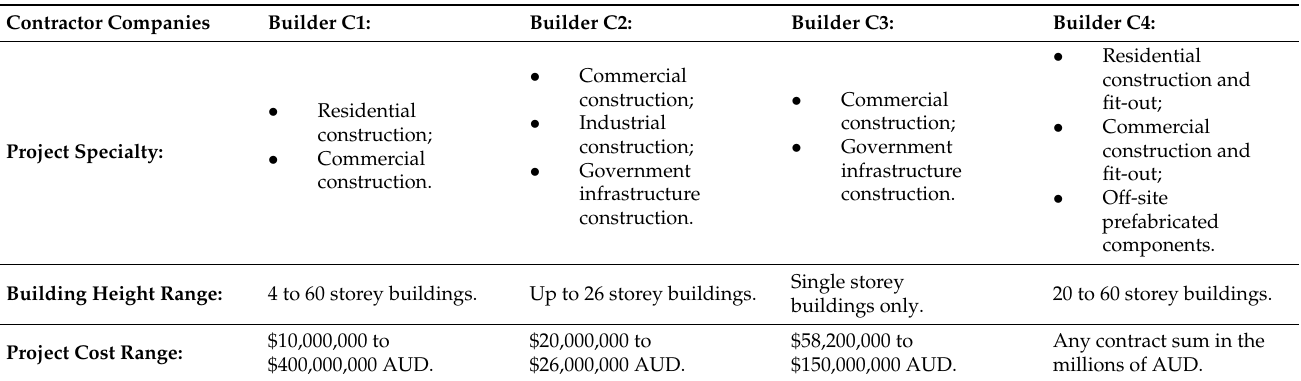
Table 1. Contractor Companies in Content Analysis of